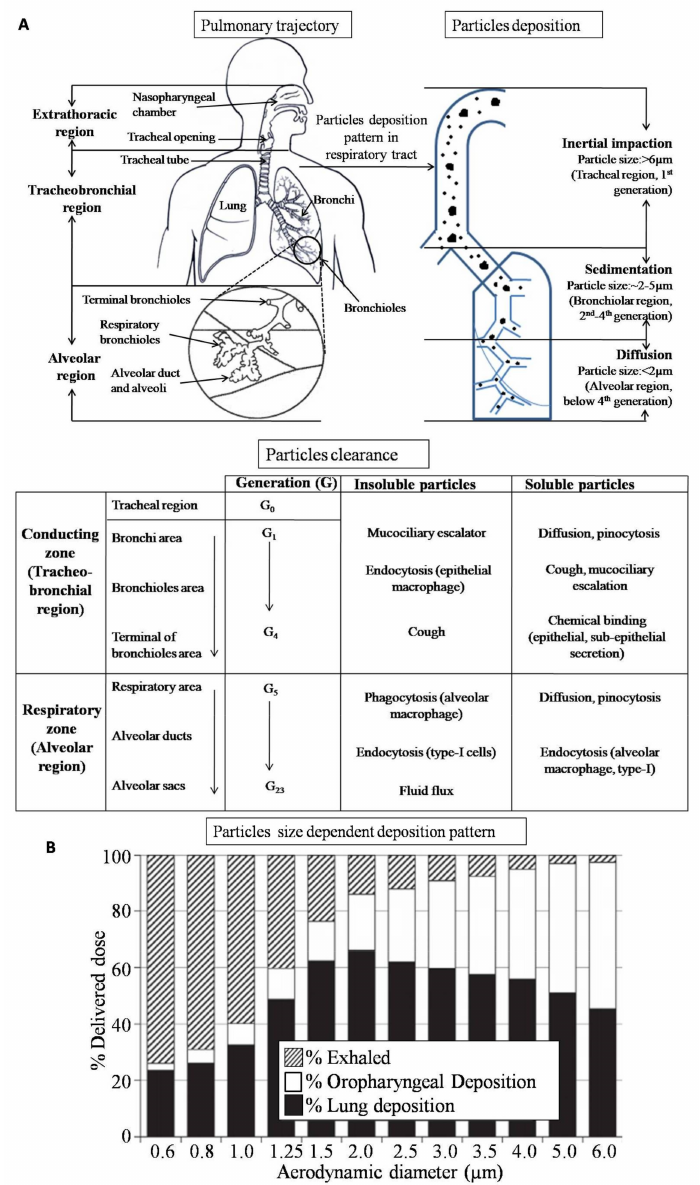
Figure 1. Airways system and particle deposition pattern. ( A ) Pulmonary tract, particle deposition pattern, and clearance mechanism. ( B ) Size-dependent deposition of particles in the respiratory tract Reproduced with permission from [44], Elsevier,